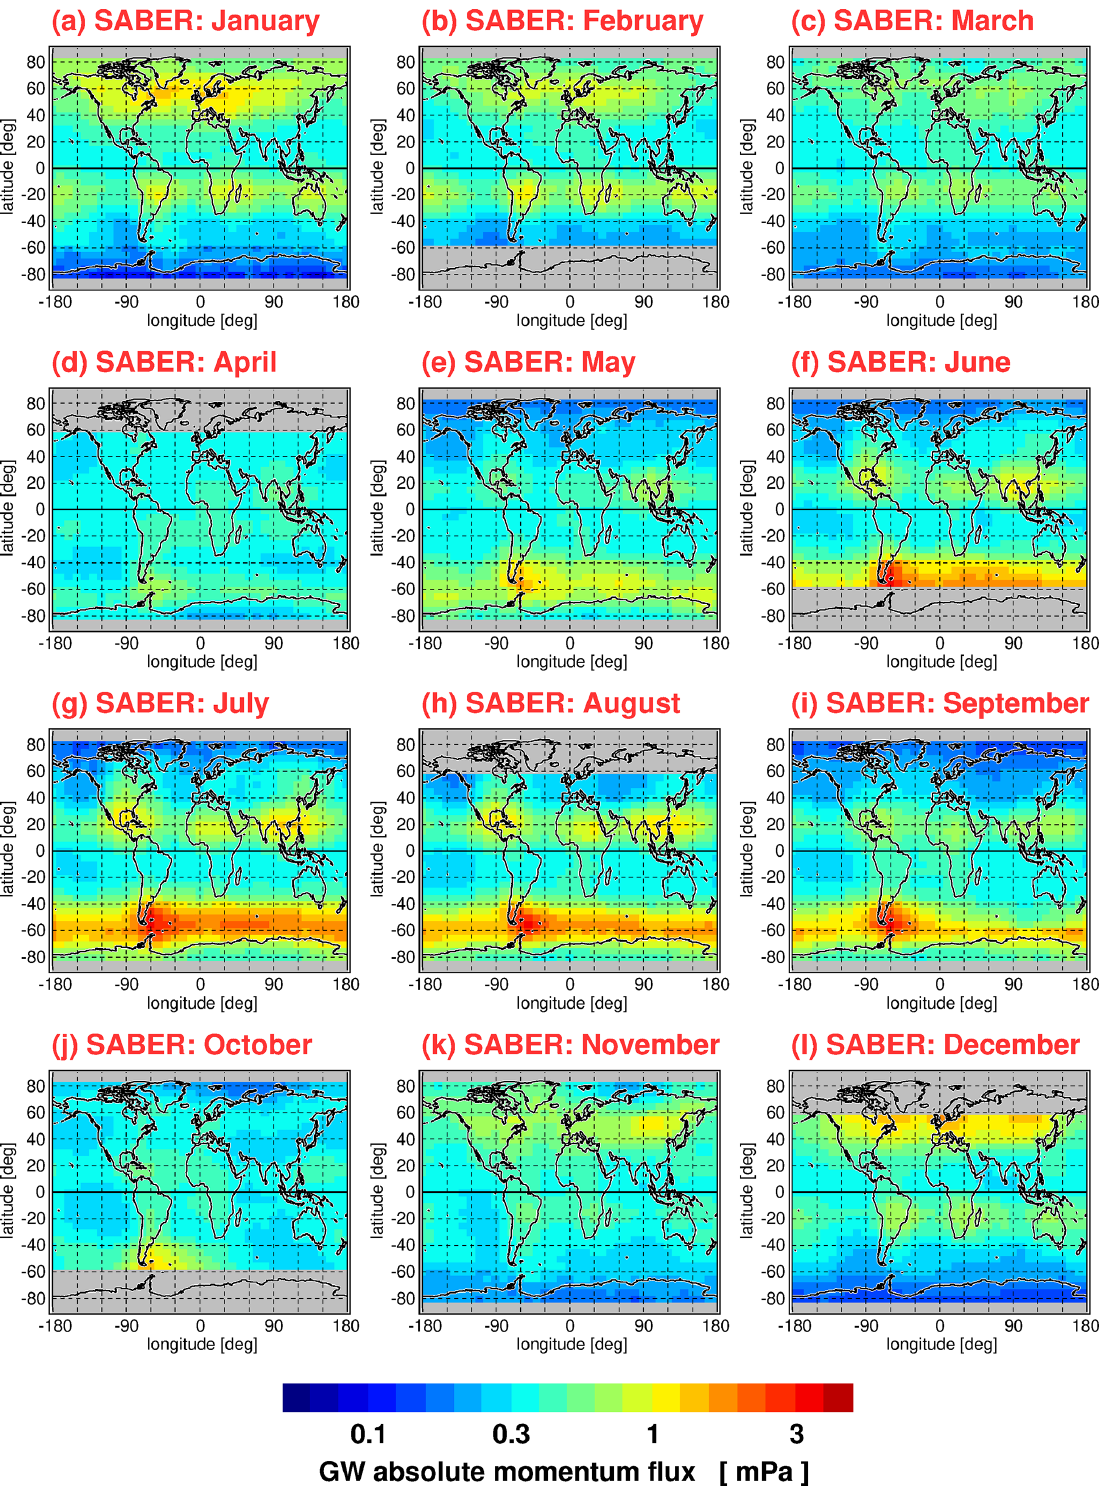
Figure 4. Same as Fig. 2 but for median SABER gravity wave (GW) absolute momentum fluxes determined in 20 ◦ × 30 ◦ (lati- tude × longitude) grid